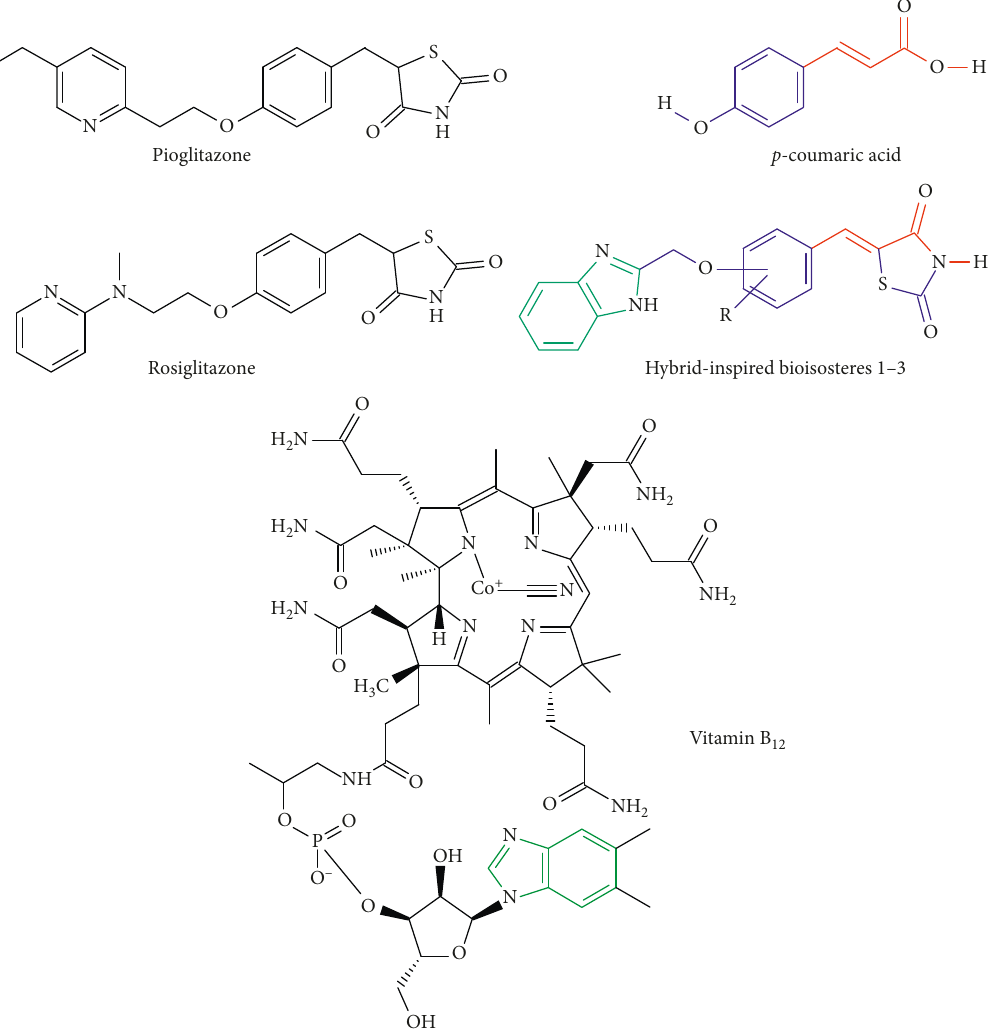
Figure 1: Antidiabetic glitazones (pioglitazone and rosiglitazone) containing pyridine and thiazolidine-2,4-dione azaheterocycles. Natural vitamin B 12 containing benzimidazole azaheterocycle (green). Natural antidiabetic p -coumaric acid and its inspired azaheterocyclic hybrids 1–3 designed in this